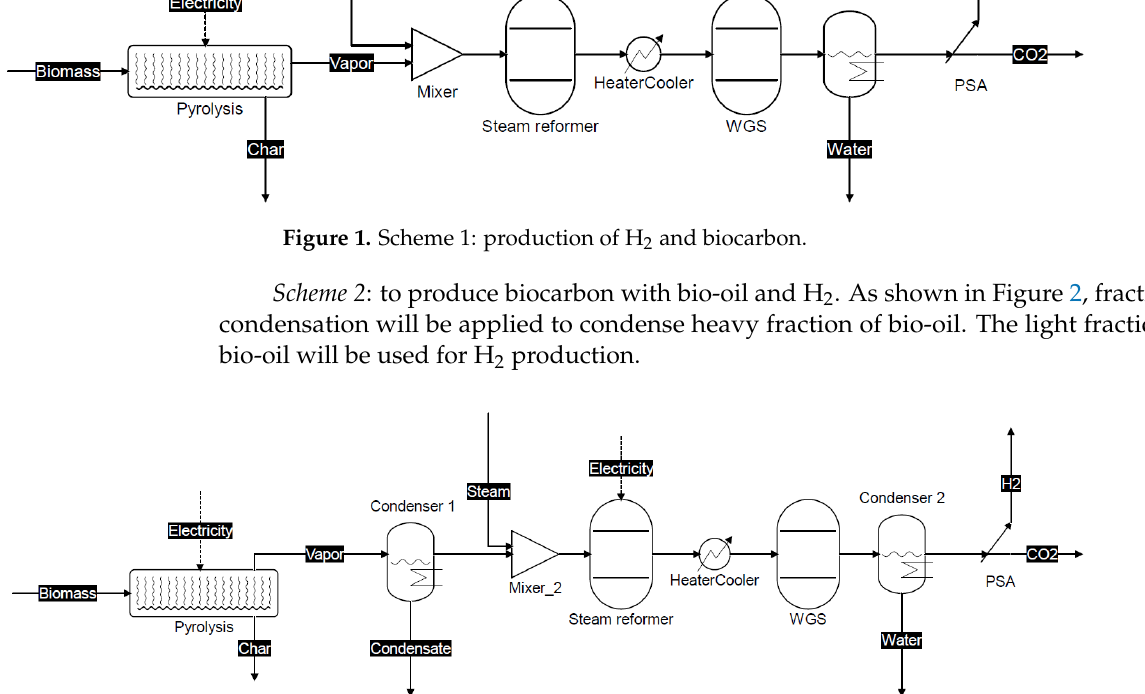
Figure 2. Scheme 2: production of H 2 , bio-oil, and biocarbon.